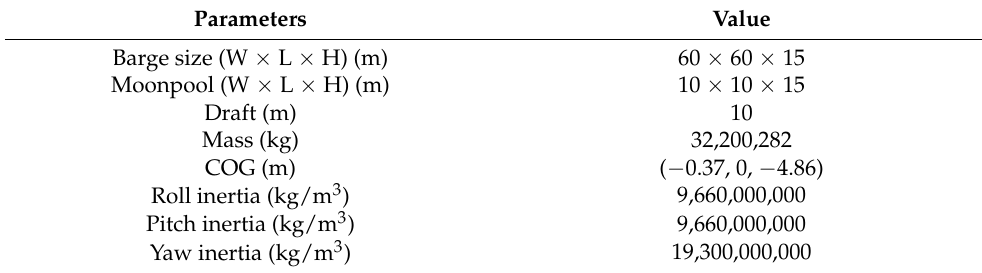
Figure 4. Conceptual diagram of the barge-type FOWT with aquaculture cage. Table 1. Main parameters of the barge-type platform.